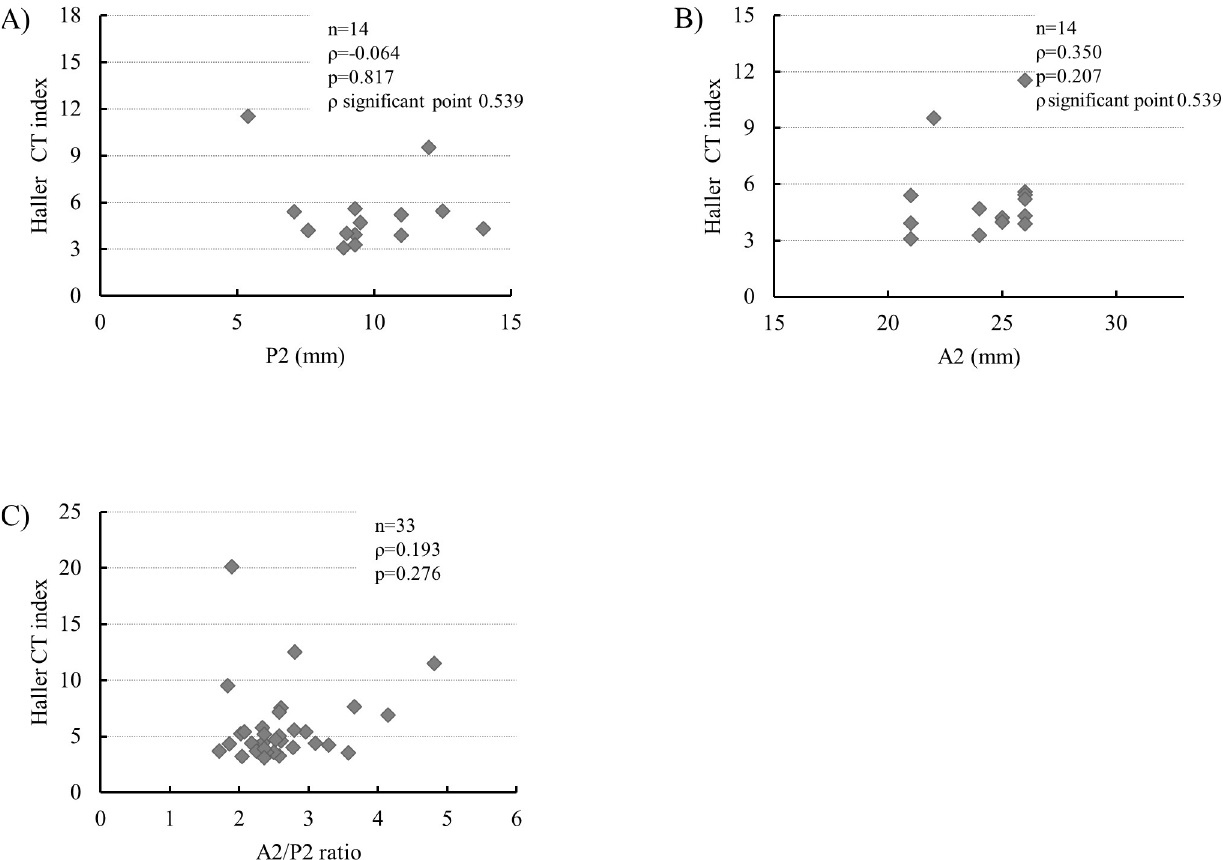
Fig 7. Correlation between mitral leaflet length and Haller CT index in patients with pectus excavatum (PE). P2 (A) and A2 lengths (B) of patients with PE older than 16 years. (C) A2/P2 ratio of all patients with PE.